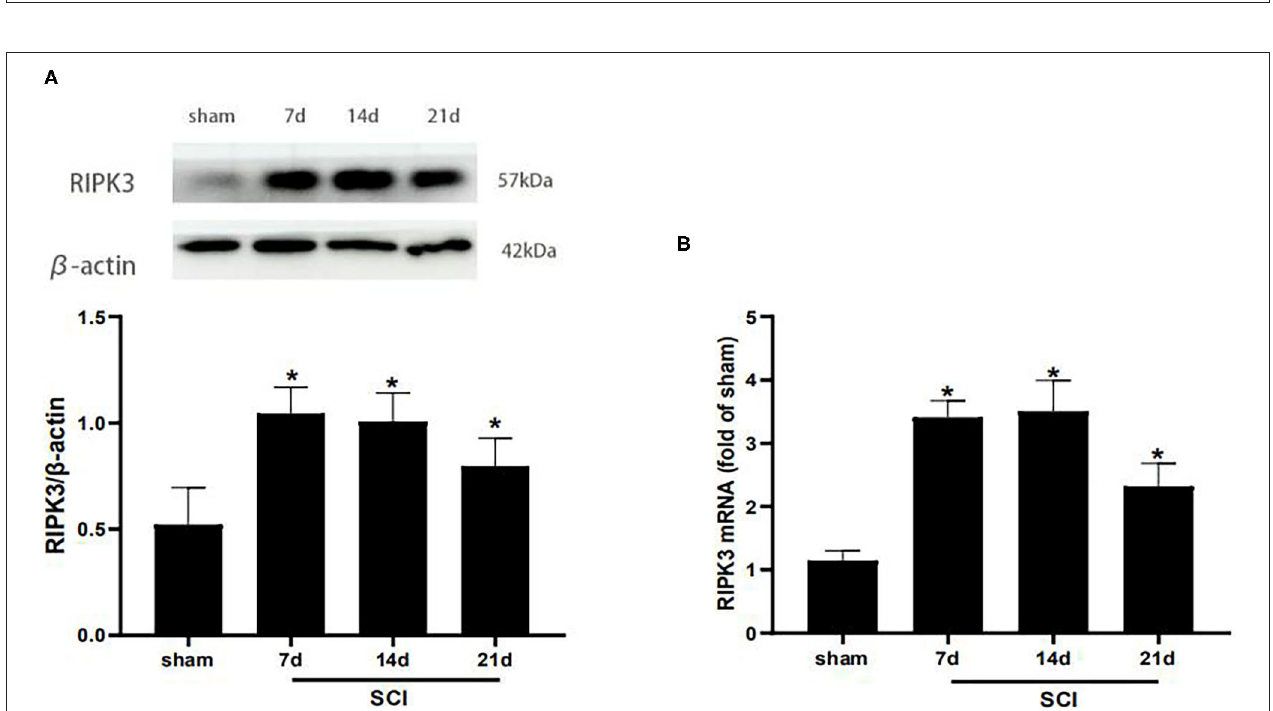
FIGURE 2 | RIPK3 was up-regulated in the dorsal horns after thoracic SCI. (A) The expression of RIPK3 in the SCI group was measured by western blot analysis on the 7th, 14th, 21th postoperative days ( n = 5 for each group). (B) Quantitative analysis of the mRNA expression of RIPK3 in the sham group and SCI group on the 7th, 14th, 21th postoperative days ( n = 4 for each group). All data were calculated as mean ± SD. * p < 0.05, vs. the sham group. Comparisons between multiple groups were carried out by one-way ANOVA and Turkey’s post-hoc analysis. RIPK3, receptor-interacting protein kinase 3.